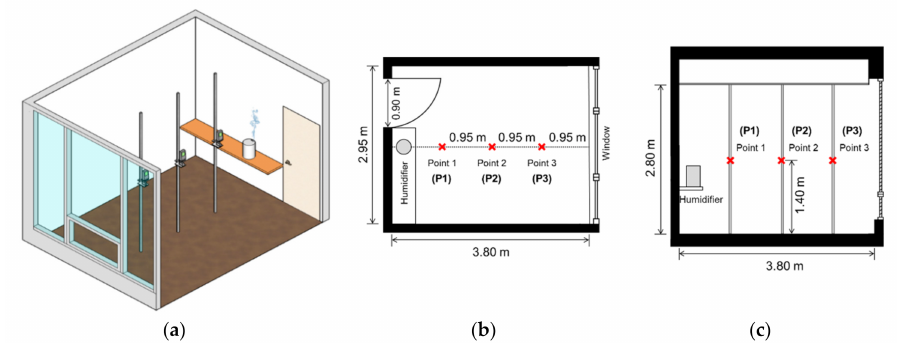
Figure 1. Experimental space and location of the experimental equipment: ( a ) perspective drawing of the test room; ( b ) plan of the experimental space; ( c ) section of the experimental space.